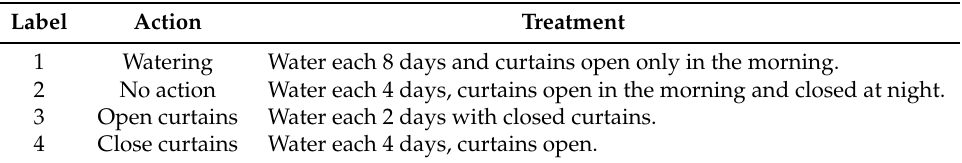
Table 1. Roses crop micro-environment